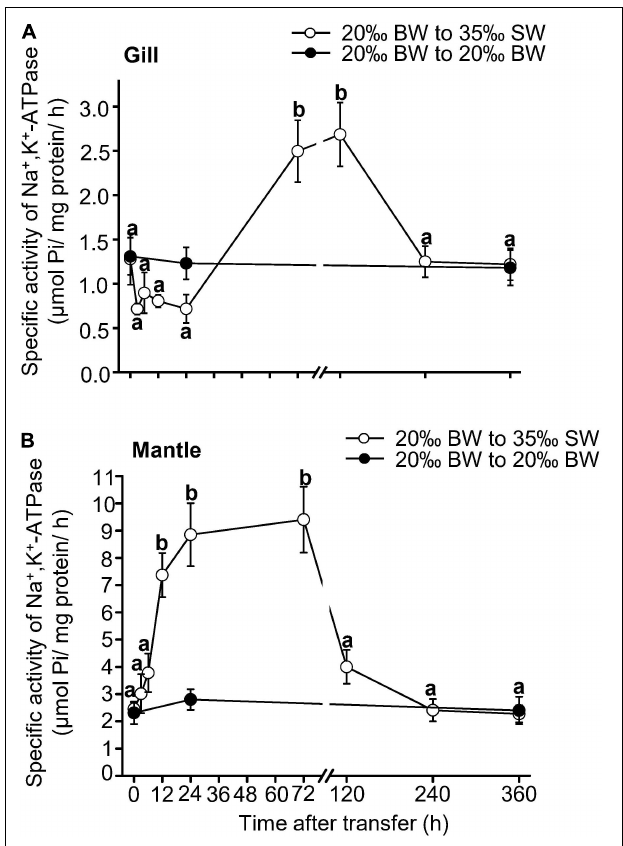
FIGURE 2 | Changes in Na + /K + -ATPase activities in the gills (A) and mantle (B) of Asian hard clams following direct transfer from 20 (BW) to 35 seawater (SW). Different letters indicate significant differences between different time points by the Tukey’s pairwise test following the (cid:104) one-way analysis of variance ( p < 0.05). No significant difference was found among time-points in the control group (from 20 to 20 means ± SEM ( N = 5).